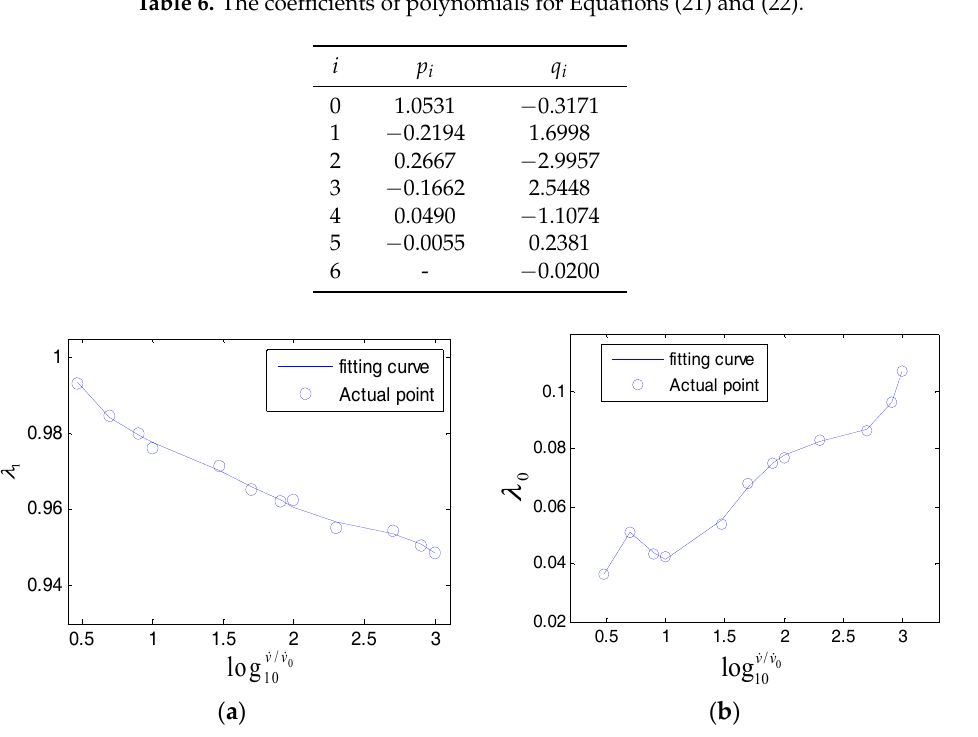
Figure 15. The relationship between similarity factors and frequency. ( a ) The relationship between λ 1 and v . ( b ) The relationship between λ 0 and